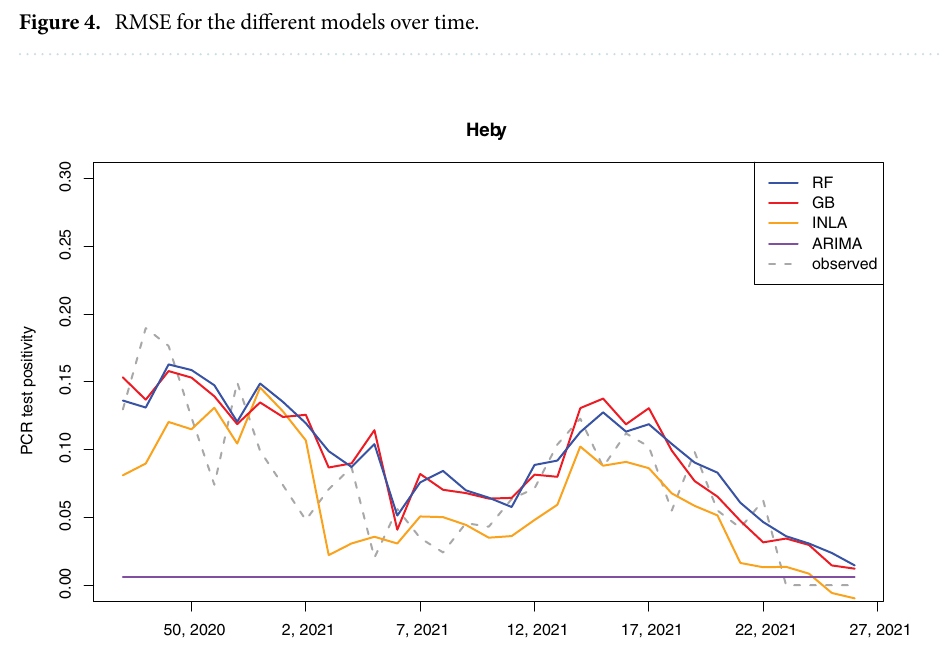
Figure 5. Time series of predicted and observed test positivity in Heby, a part of the region less strongly affected by the